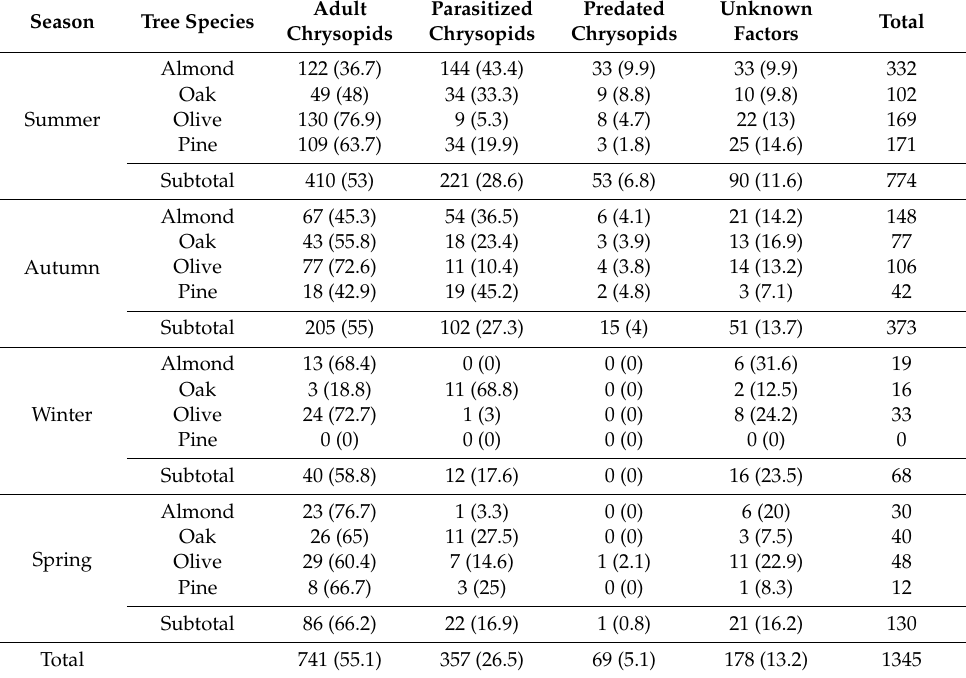
Table 2. Abundance (%) and categories of juvenile stages in almond, oak, olive and pine trees by season.